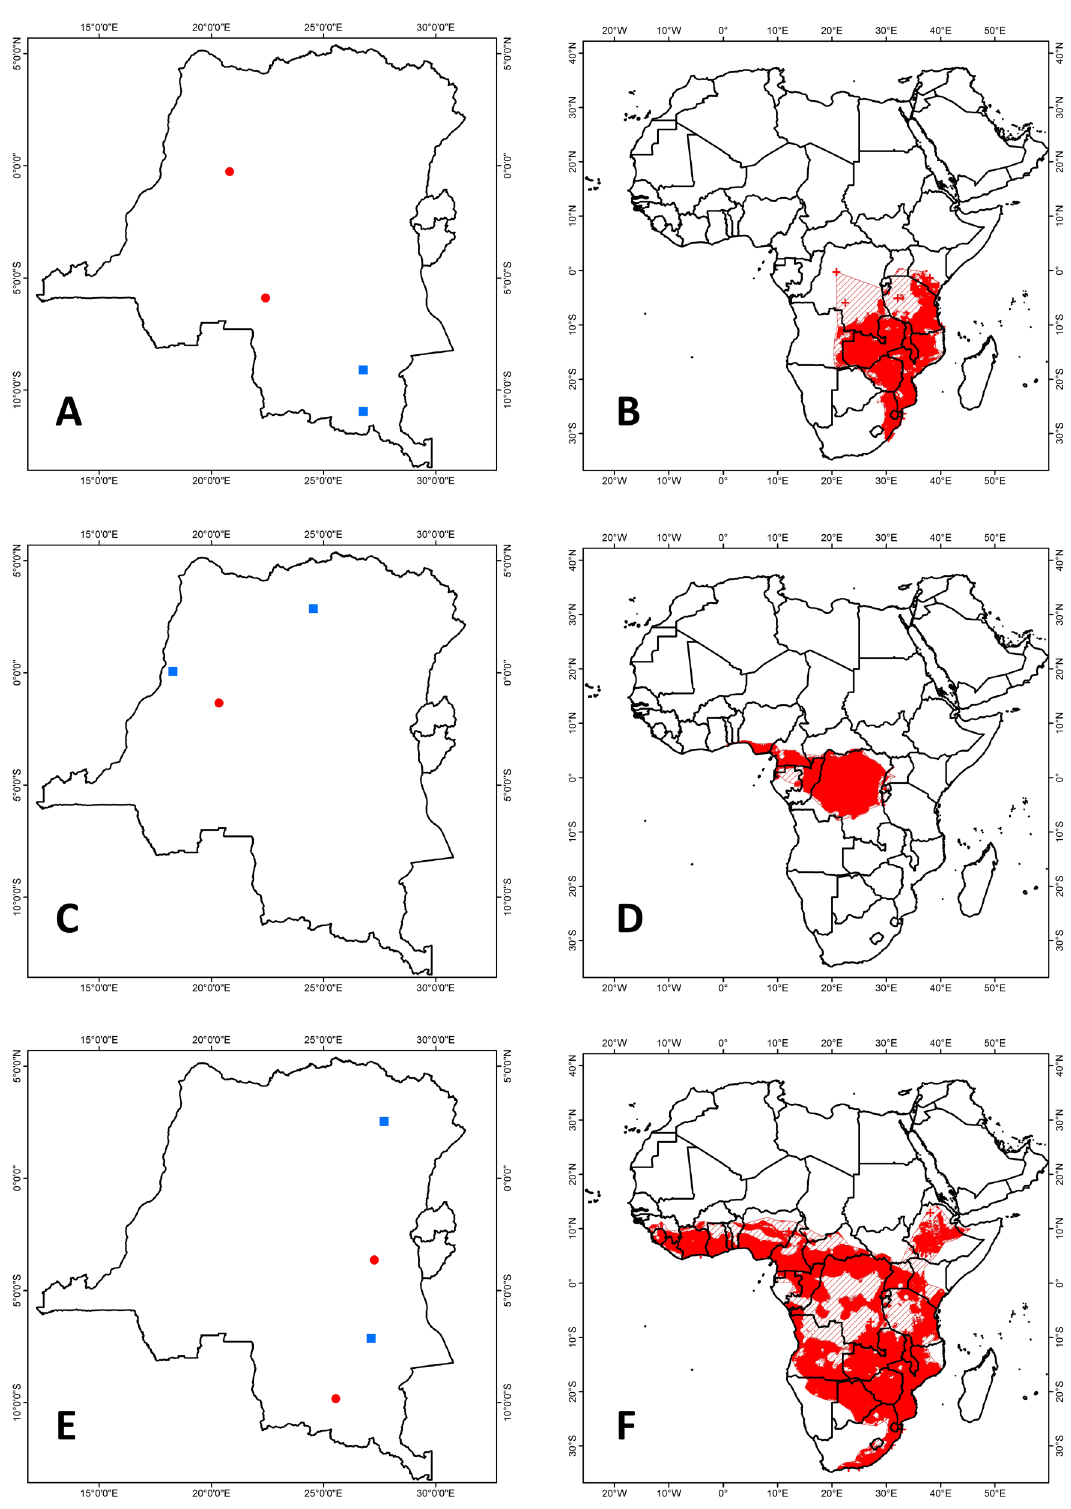
Fig. 34. Distribution maps. A–B . Kerivoula argentata Tomes, 1861. C–D . Kerivoula cuprosa Thomas, 1912. E–F . Kerivoula lanosa (A. Smith, 1847). A, C, E. Distribution in the CRB area. B, D, F.